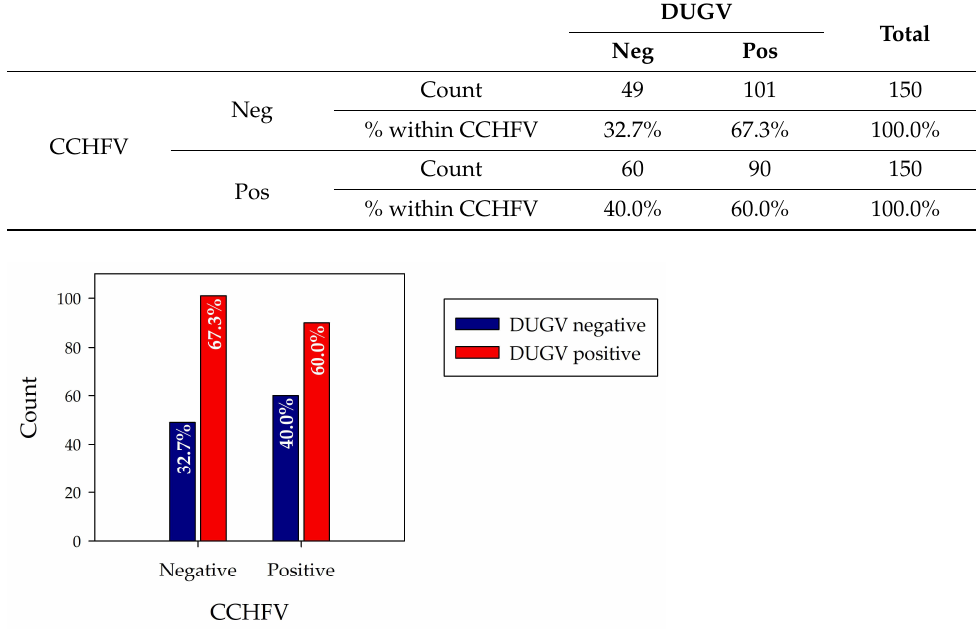
Figure 3. Corrected OD values for 300 Nigerian cattle sera: The distribution patterns between CCHFV seropositive sera (red dots) and CCHFV seronegative sera (green dots) do not apparently vary between each other. Table 2. Cross-tabulation table ELISA (CCHFV × DUGV).